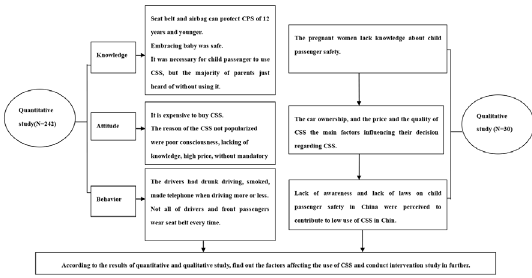
Fig 1. Chart of the Study